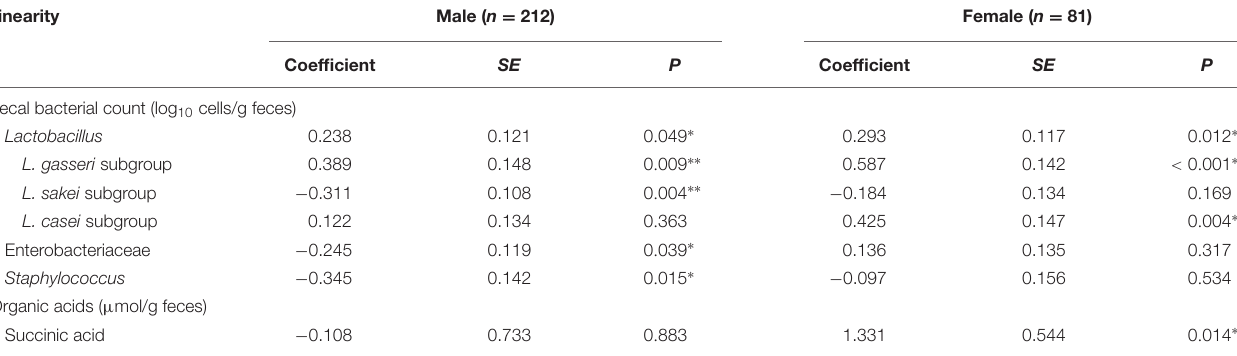
TABLE 4 | Linearity between the frequency of yogurt consumption and the fecal microbiota and organic acids, as analyzed by generalized linear model. Linearity Male ( n = 212) Coefficient SE